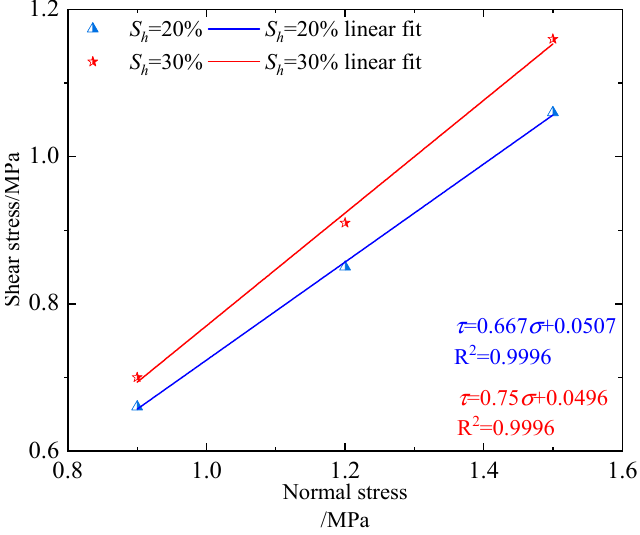
Figure 12. Mechanical parameters of nature gas hydrate sediments under different normal stresses.